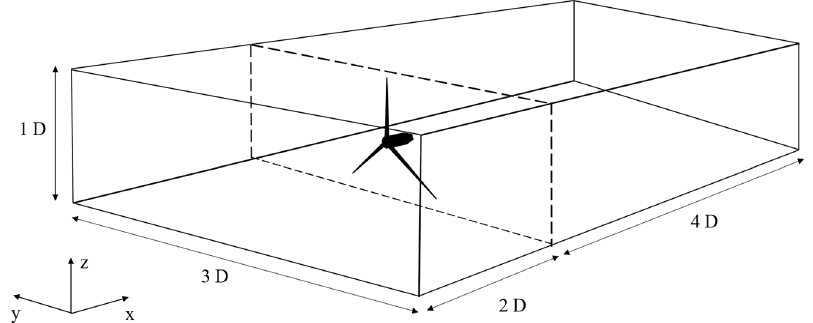
Figure 8. Schematic of the local area around turbine of CNNs sub-domain. The dashed line shows the plane of the rotor.